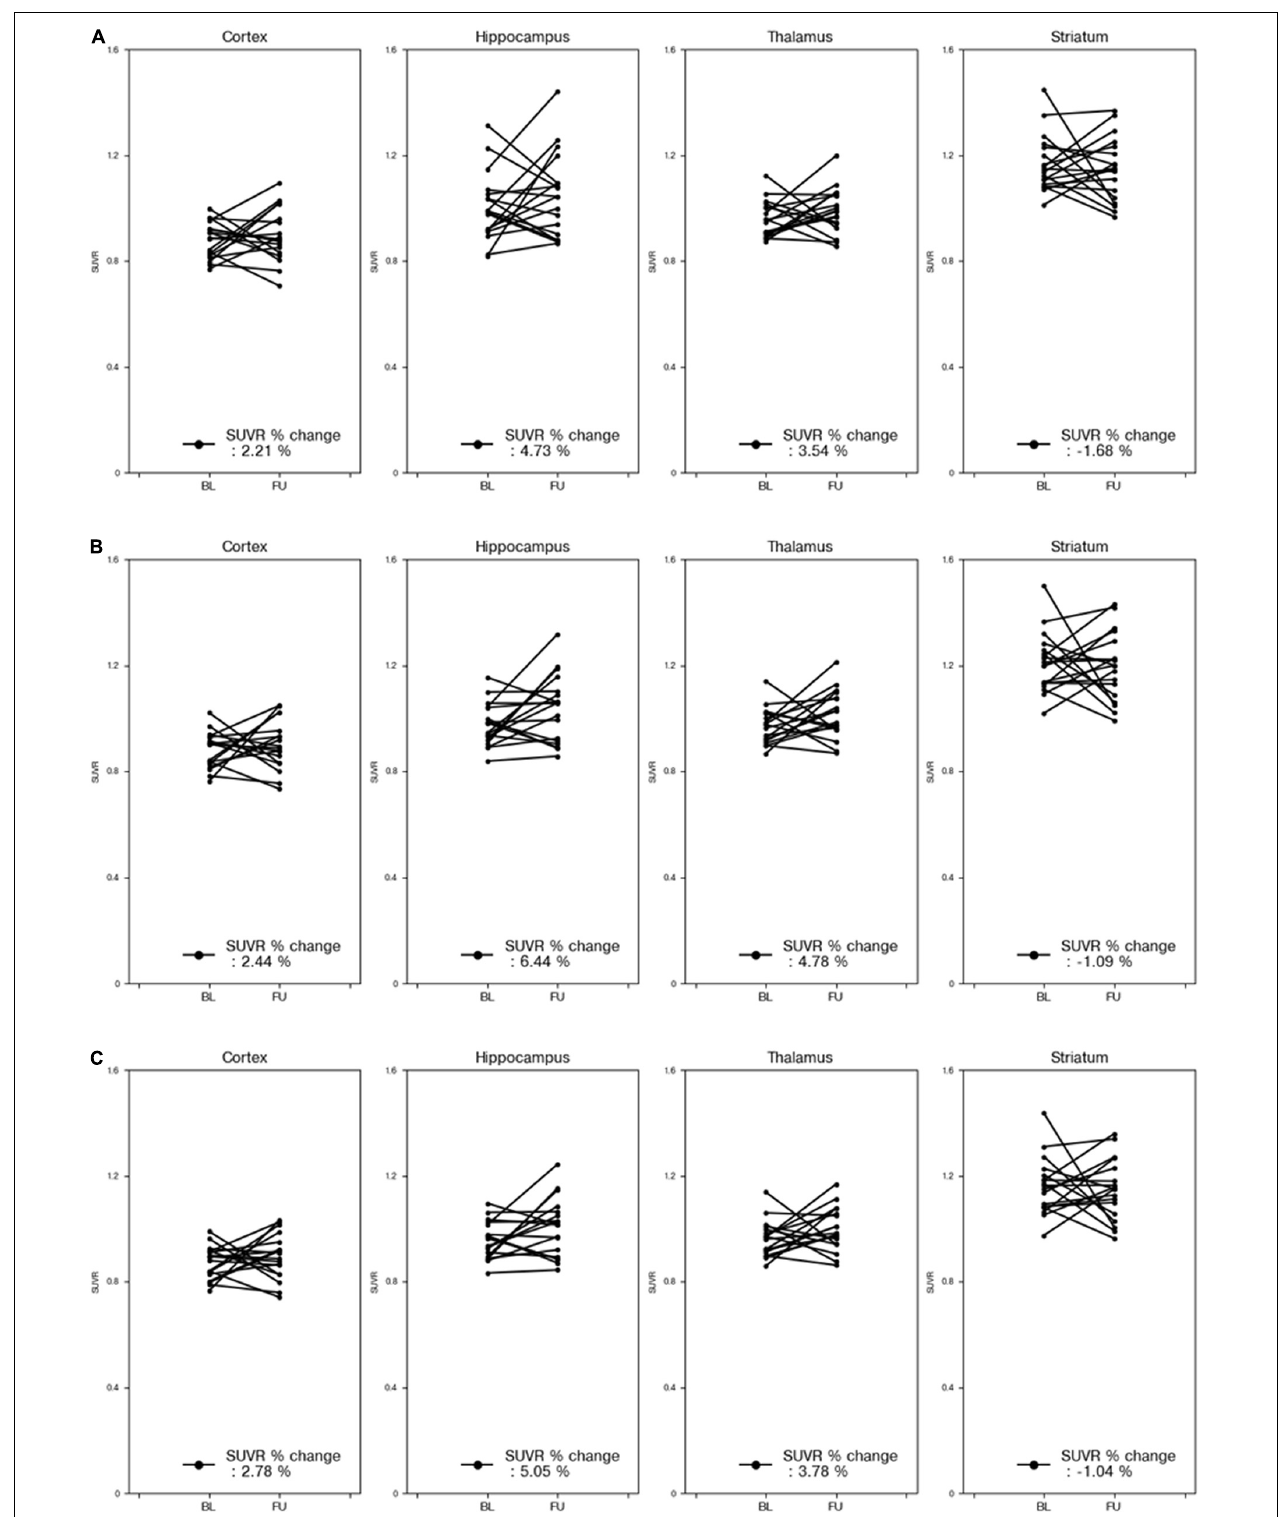
FIGURE 6 | % changes in SUVR for each part of 18 mice before and after treatment. The reference area of the SUVR was the cerebellum. Percent change in SUVR obtained using VOI DL (A) . Percent change in SUVR obtained using VOI iGT (B) . Percent change in SUVR obtained using VOI GT (C) . Results for cortex, hippocampus, striatum, and thalamus are presented sequentially from the left column. VOI DL , deep learning generated VOI; VOI iGT , deep learning label VOI; VOI GT , template-based VOI; baseline (BL—before treatment); follow-up (FU—after